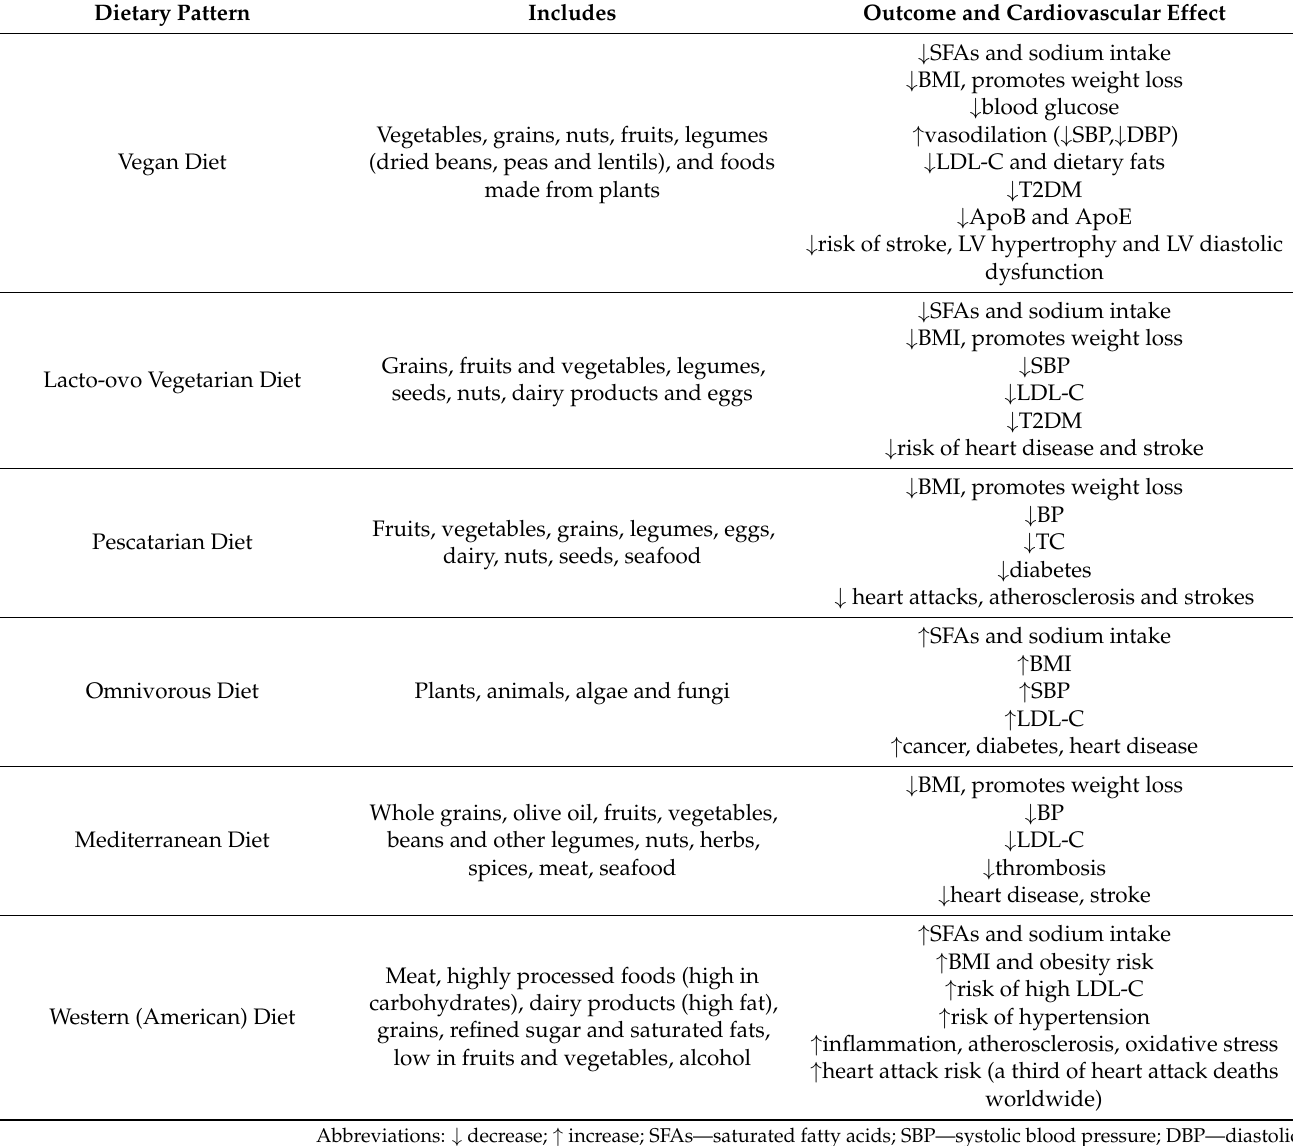
Table 3. Comparison between vegan diet and other diets with respect to CV